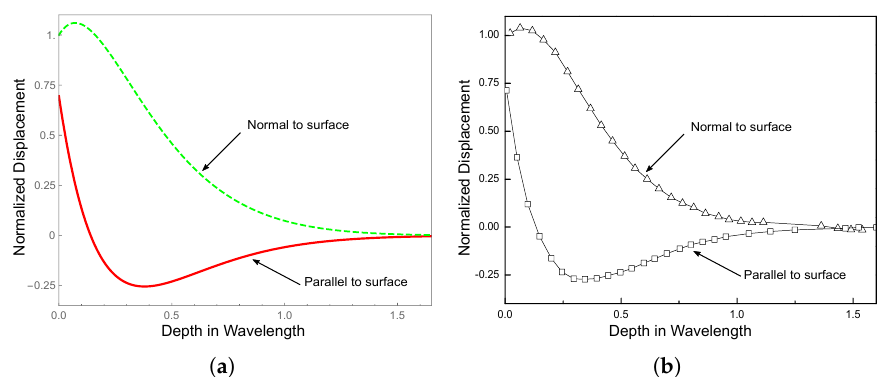
Figure 2. The comparison of displacement curves: ( a ) results from the present method; and ( b ) results from